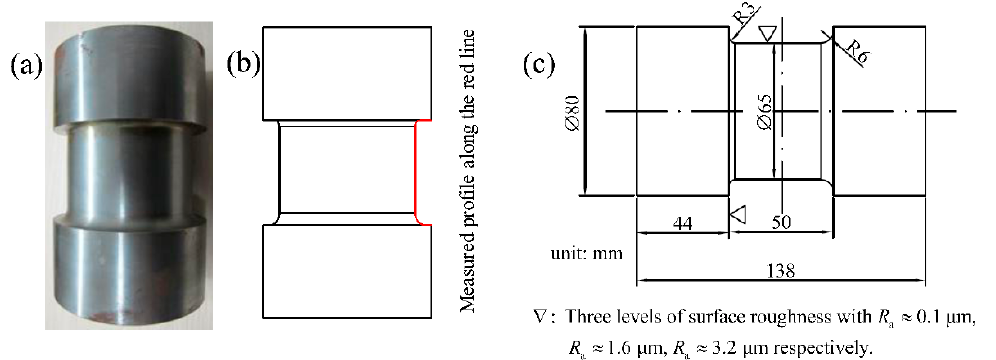
Figure 1. The fatigue test specimen. ( a ) the machined stepped shaft, ( b ) the schematic describing the profiled roughness and ( c ) the geometric dimensions of the stepped shaft.